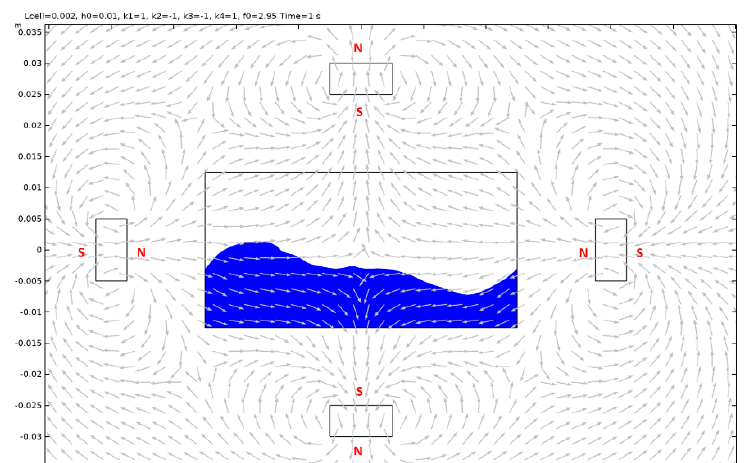
Figure A25. Case 11.